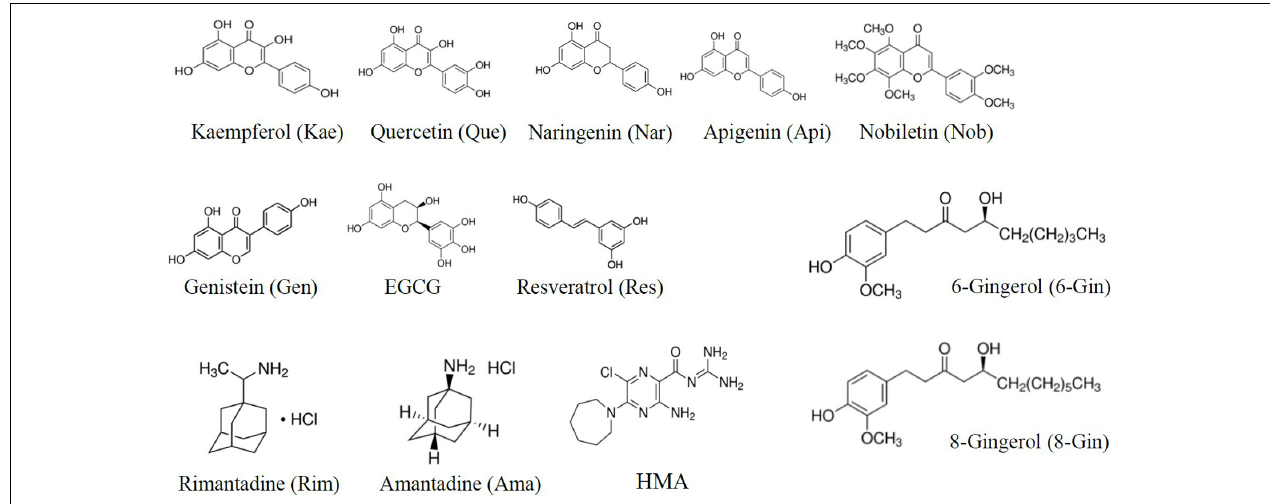
FIGURE 2 | Structures of inhibitors used in this study. Substance classes were flavonols (quercetin, kaempferol), flavones (apigenin, nobiletin), isoflavones (genistein), flavanones (naringenin), gingerols (6-gingerol, 8-gingerol), polyphenols (resveratrol), and catechins (epigallocatechin gallate, EGCG), as well as the classical